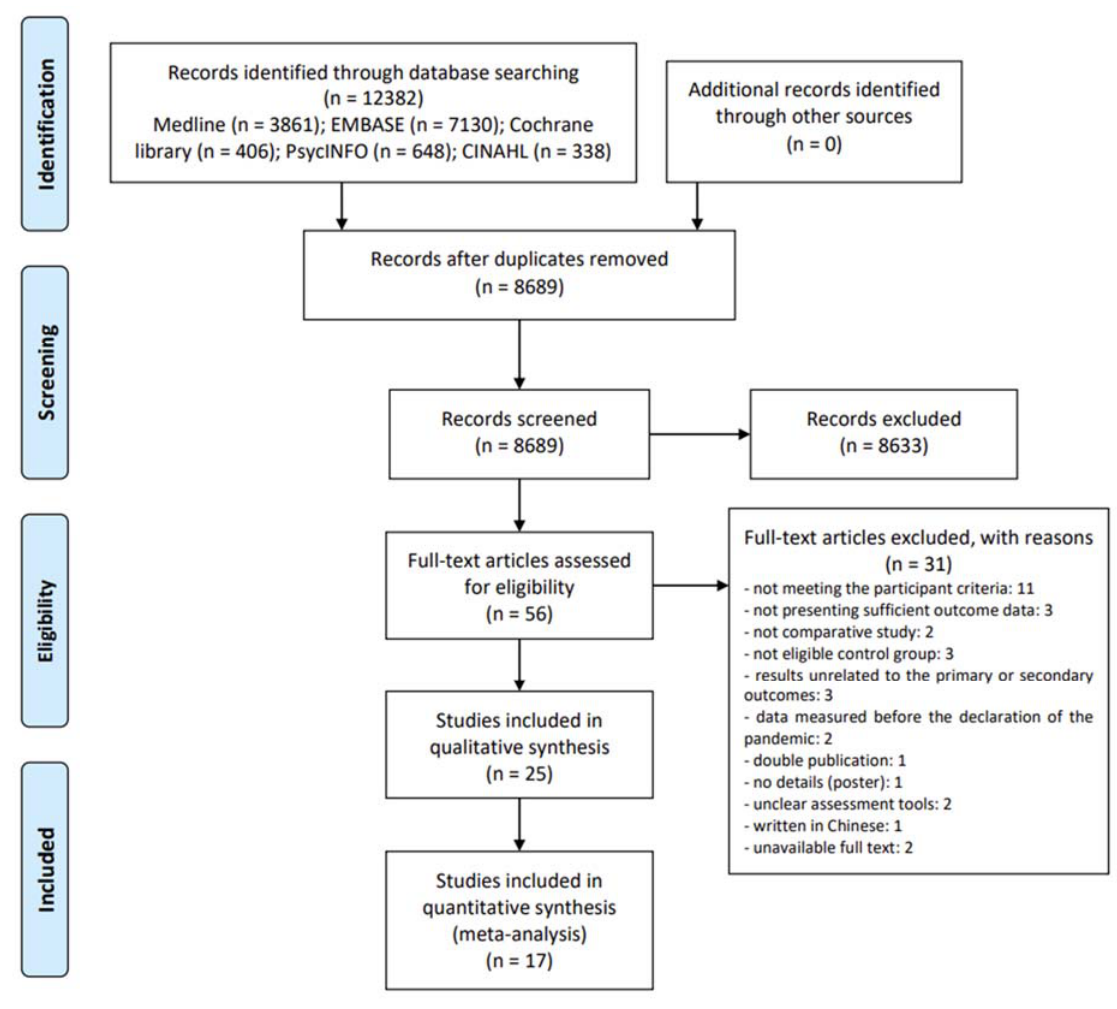
Figure 1. PRISMA Flow diagram.